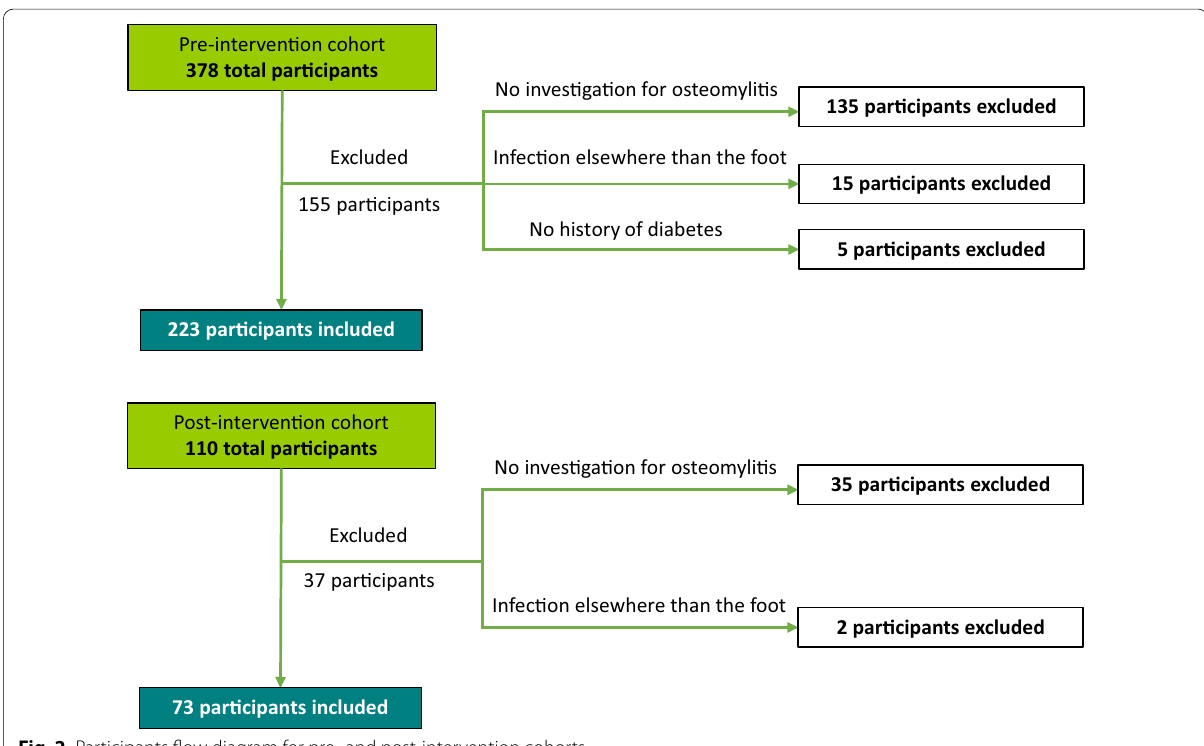
Fig. 2 Participants flow diagram for pre‑ and post‑intervention